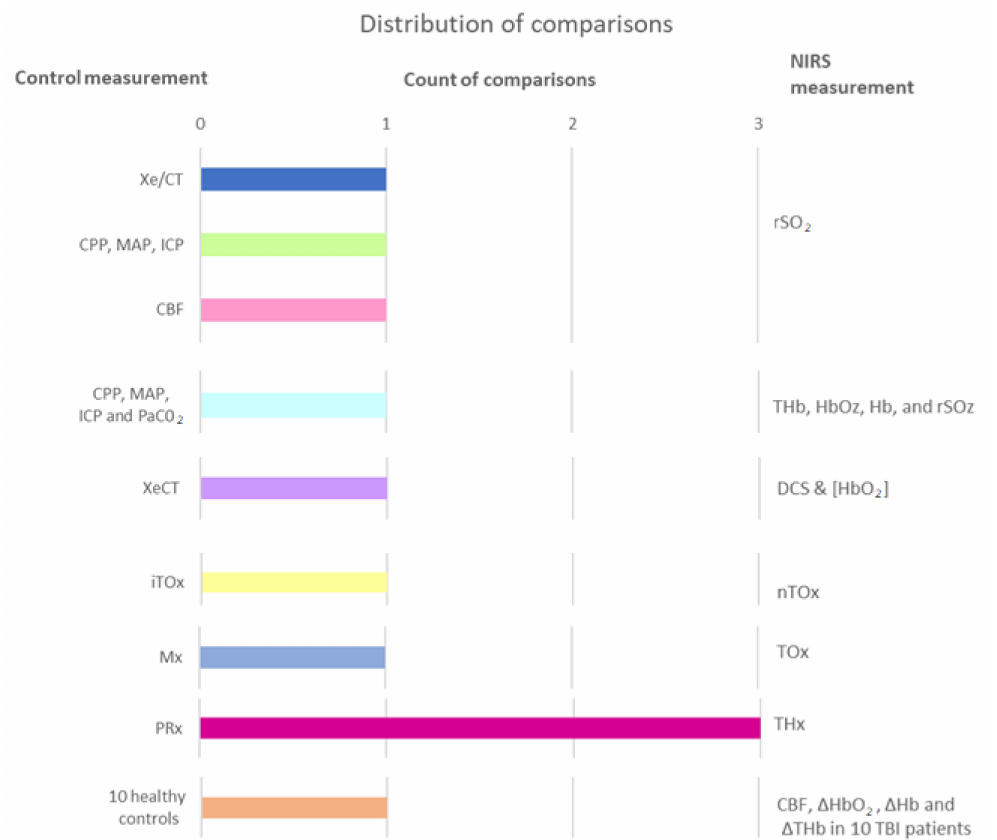
Figure 14. Comparisons found in the evidence on NIRS-derived autoregulation in